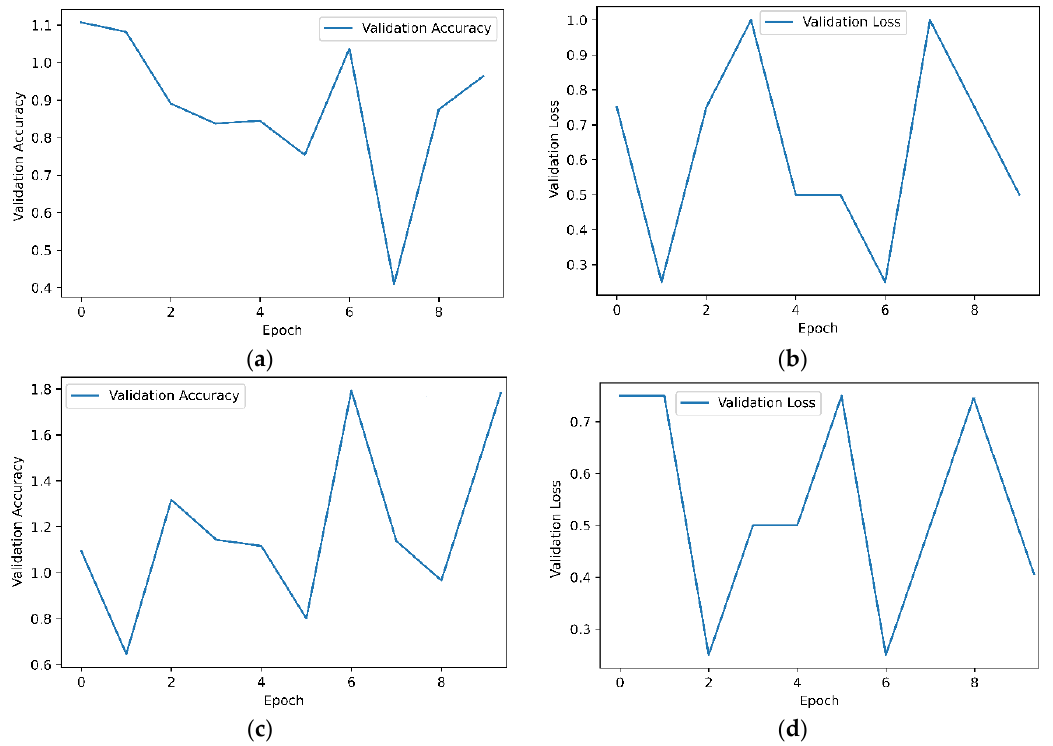
Figure 7. Model loss and accuracy of Conv2D models during cross validation. ( a ) Model accuracy of DenseNet; ( b ) nodel loss of DenseNet; ( c ) model accuracy of ResNet; ( d ) model loss of ResNet. The wall quality dataset was fitted with the Conv2D ResNet model, which acted as a